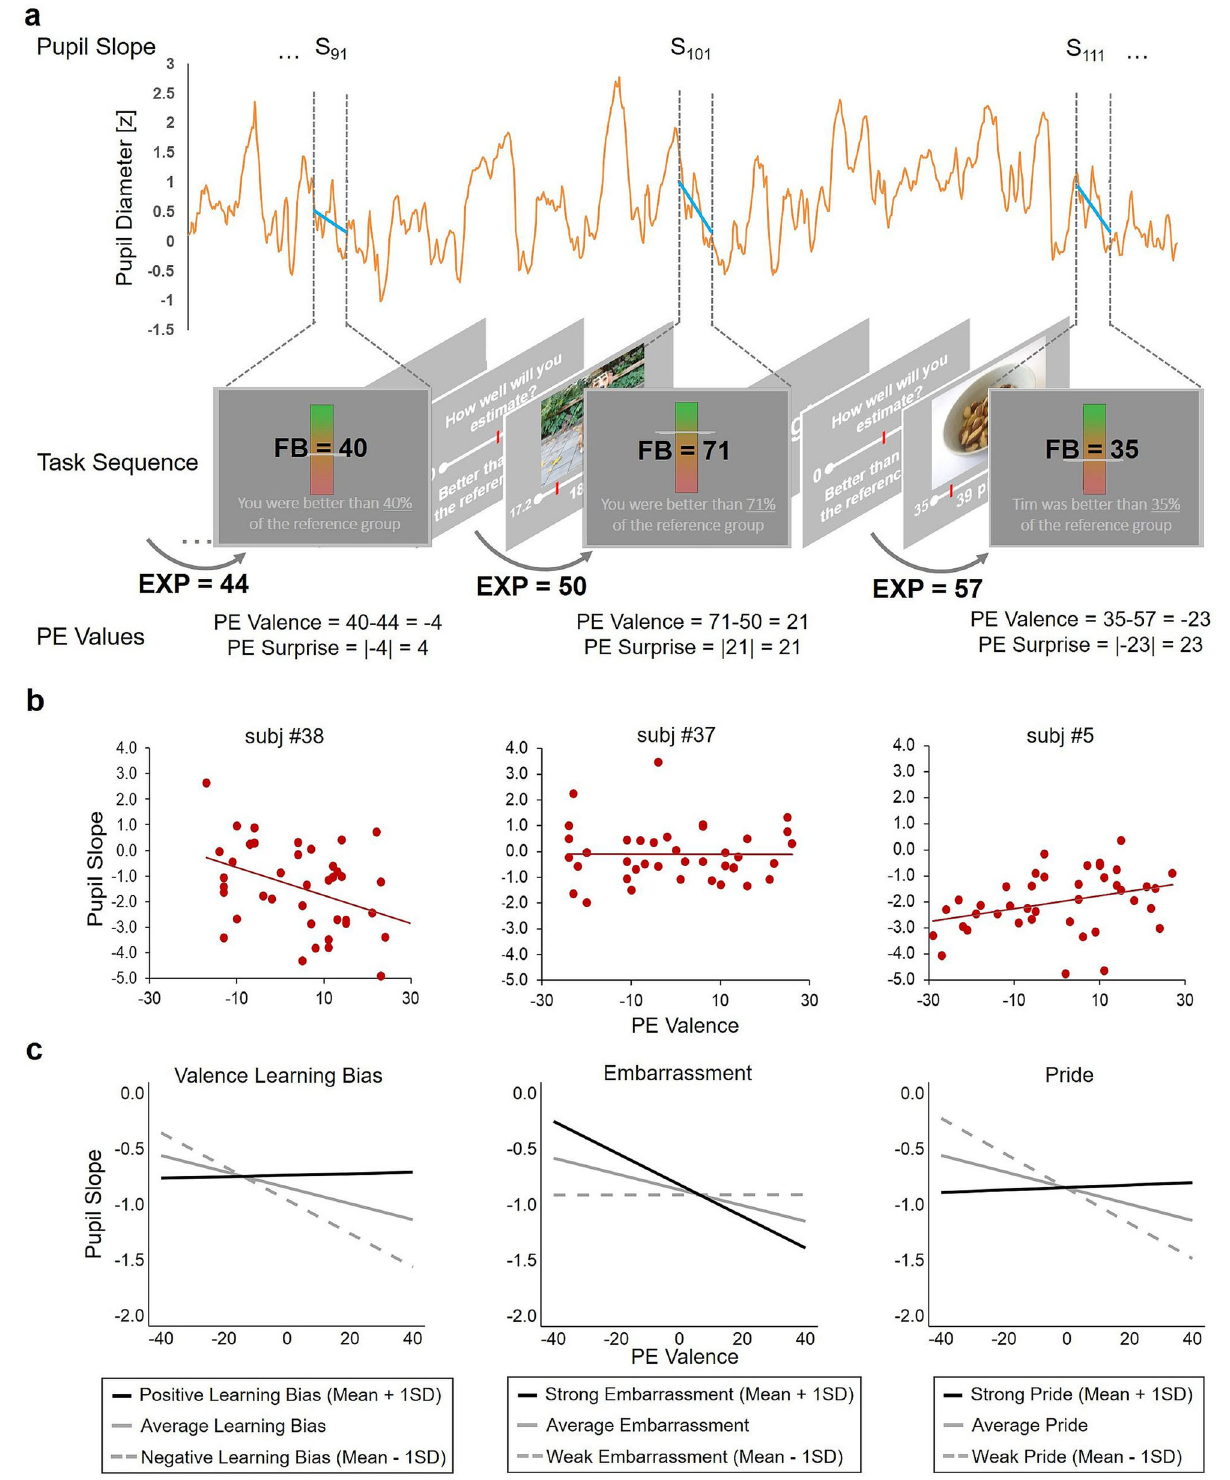
Fig. 2 Association of pupil slopes with prediction error (PE) valence and individual pupil response differences explained by differences in Valence Learning Bias, embarrassment and pride experience. a Example of pupil diameter trace over three trials for one subject (orange line) and trial-speci fi c fi tted linear slopes (blue lines) for the feedback phase of each trial. PE values are calculated with the participant ’ s current performance expectation (EXP) and the following feedback value (FB), and PE valence represents the signed PE while PE surprise represents the unsigned PE. b Three exemplary scatter plots show the association of pupil slopes with PE valence and illustrate the variance between subjects. Trend lines are fi tted by linear regression. c Illustration of the impact of the three between-subject covariates, Valence Learning Bias (left), embarrassment (middle) and pride experience (right) explaining differences in the associations of PE valence and pupil slope. The plots show the data as predicted by the multi-level models for the mean covariate (grey line) and the mean covariate + / − 1 standard deviation (SD; black line and gray dashed